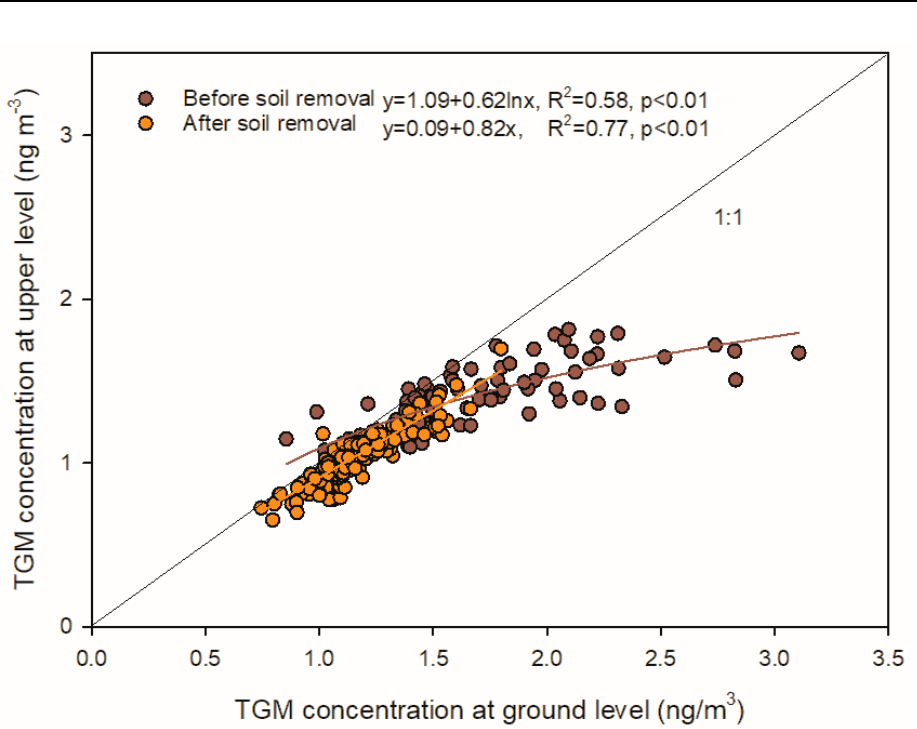
Figure 3. Comparison of daily average concentration at two heights (1.8 and 42.3 m) prior to and after brownfield remediation at the Syracuse CoE.